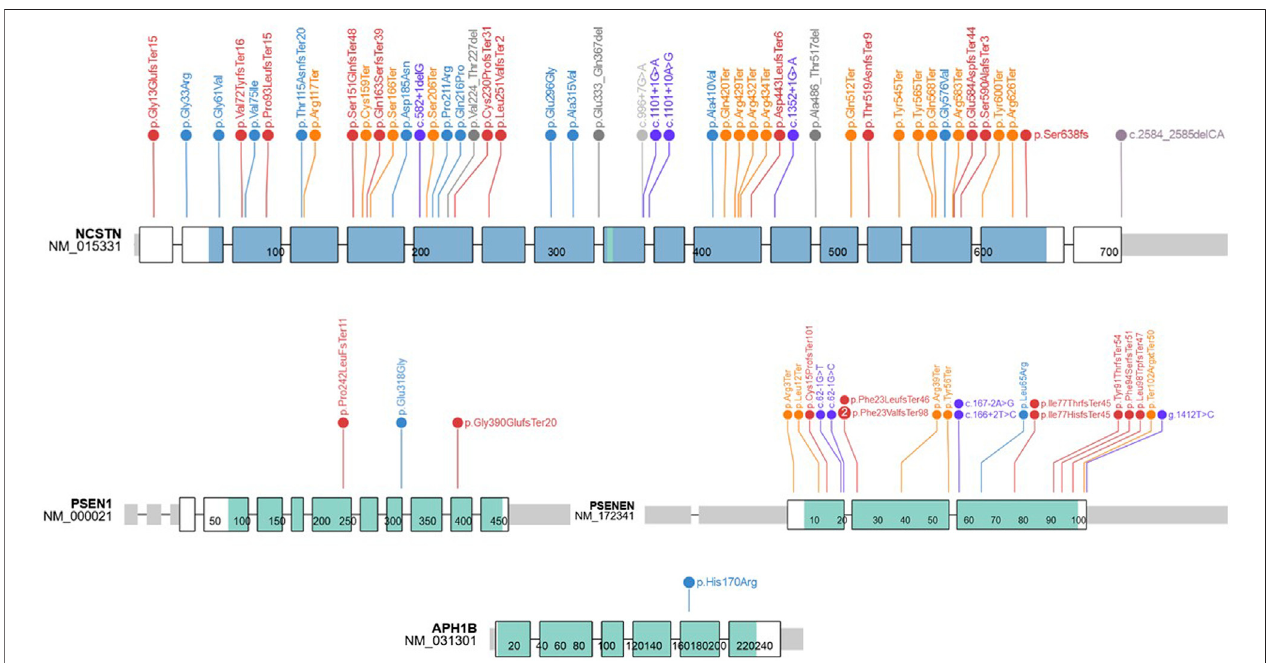
FIGURE 1 | HS-associated variants in genes encoding proteins of the gamma secretase